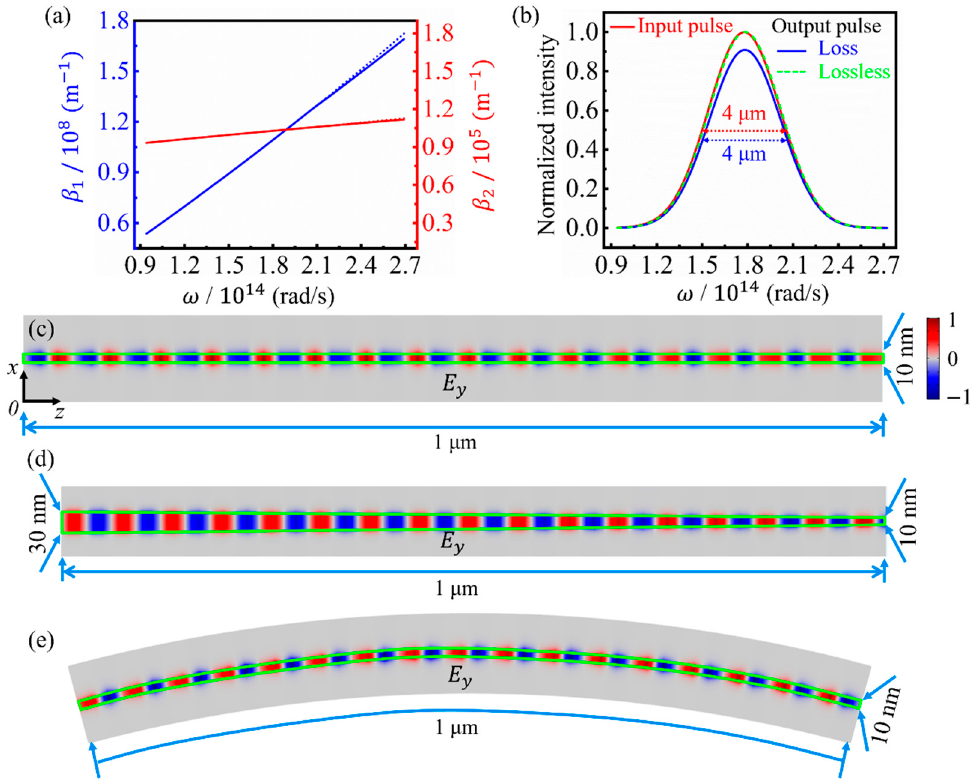
Figure 3. ( a ) Dependences of the real and imaginary parts of β on the angular frequency of incident wave for the fundamental GSPP mode. ( b ) The envelope profiles of pulses with a center wavelength of 10.6 μ m and a FWHM of 4 μ m in the frequency domain, probed on the input plane (red solid line) and the output plane (blue solid line), respectively. The green dashed line shows the pulse on the output plane without considering the propagation loss. Distributions of E y on the center planes of dielectric spacers ( y = 0) in GNRGWs with the straight ( c ), wedge-shaped ( d ), and curved ( e ) GNRs, respectively, for λ = 10.6 μ m. The interior areas of the green boxes represent GNRs. All electric field distributions share the same color legend.